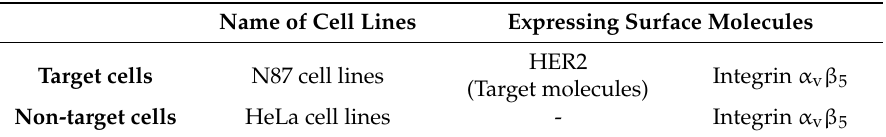
Table 1. Cell lines used in the experiments.